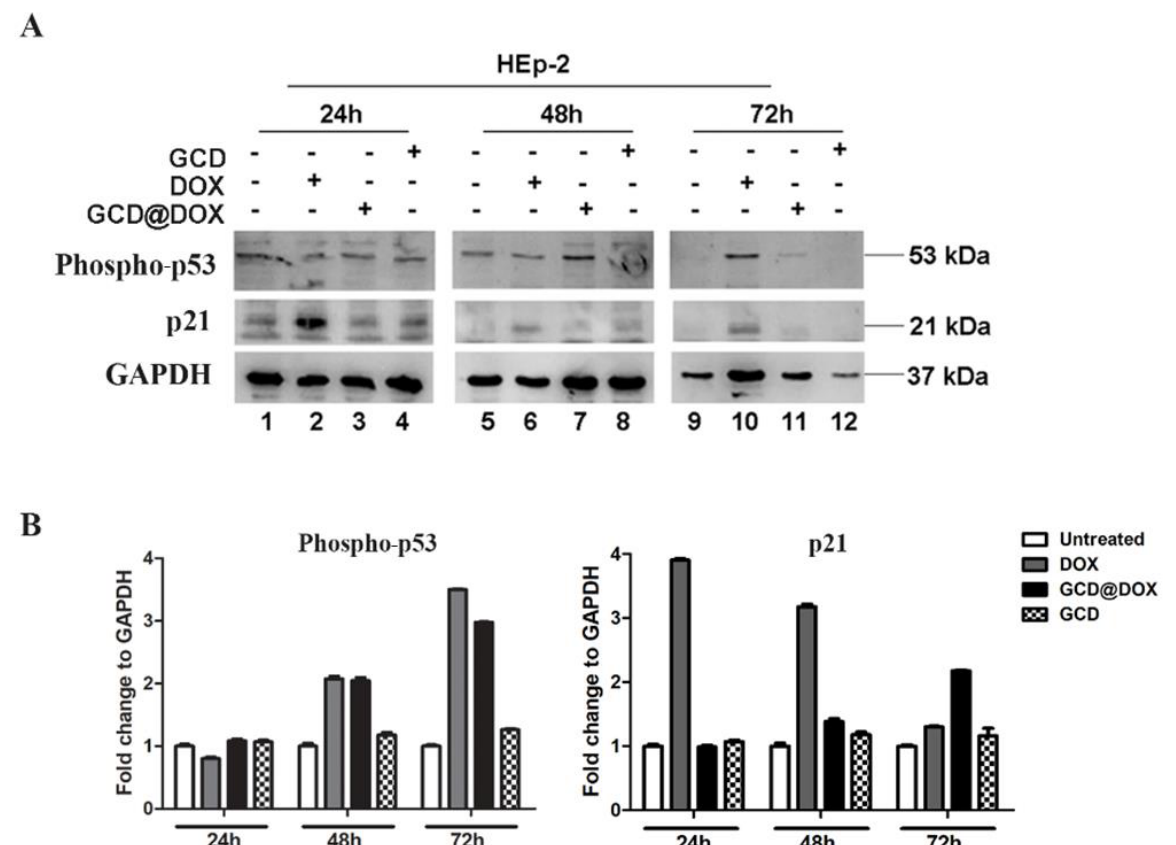
Figure 2. Phospho-p53 and p21 protein expression in GCD@DOX-, GCD- and DOX-treated cells. HEp-2 cells were treated or untreated with 25 µ g/mL of GCD@DOX for the indicated time (24 h, 48 h and 72 h). DOX and GCD were used as controls. ( A ) An equal amount of proteins was separated by polyacrylamide gel electrophoresis and probed with a specific antibody to phospho-p53 and p21. GAPDH was used as housekeeping gene. ( B ) The quantitative densitometric analysis for phospho- p53 and p21 band intensities was determined using ImageJ software and expressed as fold change over the appropriate housekeeping gene.